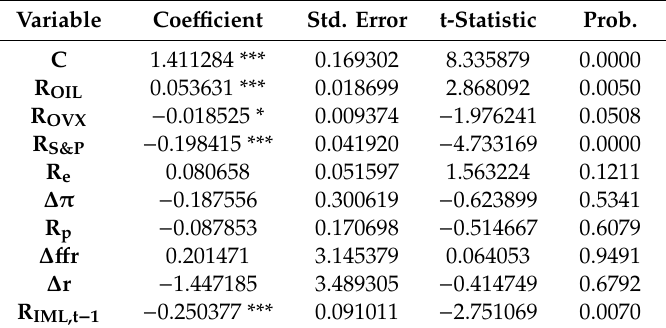
Table 11. OLS regression results (post financial